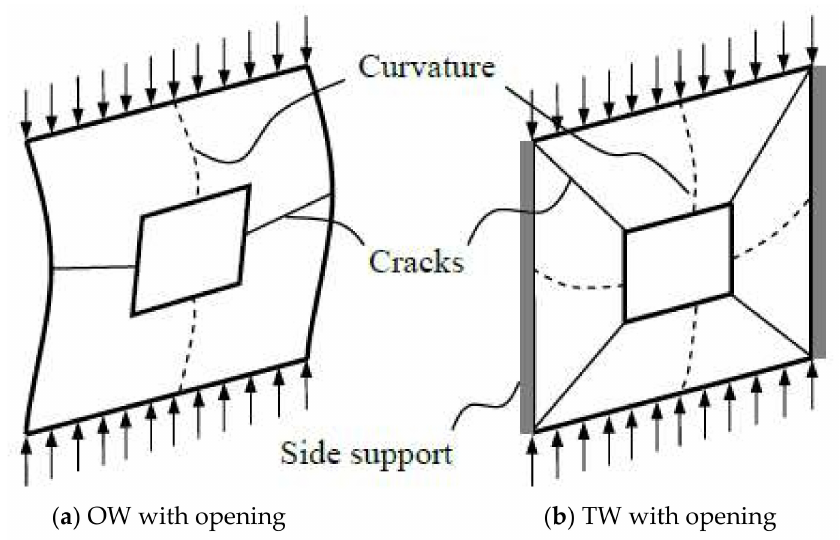
Figure 1. Response of walls having opening with respect to boundary